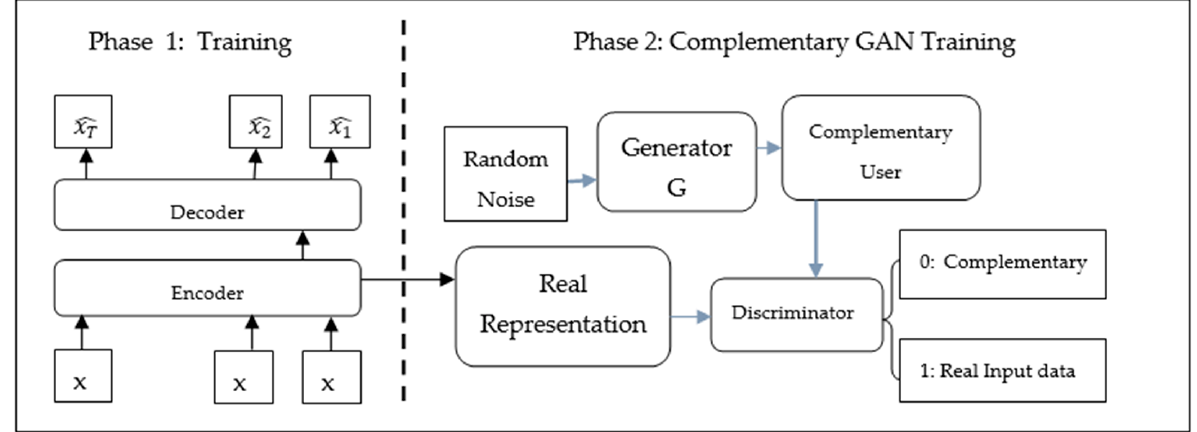
Figure 5. The training architecture of OCAN.